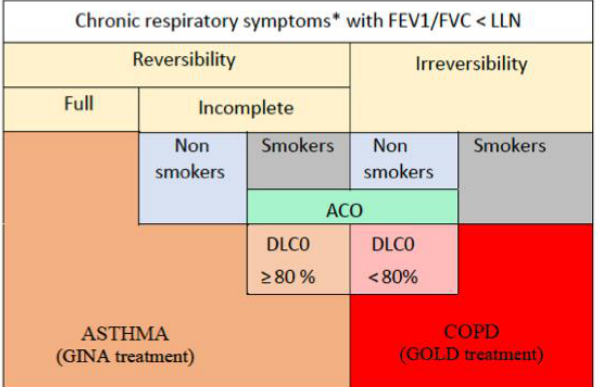
Figure 4. The strategy to select GINA or GOLD treatment among Vietnamese patients with chronic obstructive respiratory diseases based on symptoms, spirometry with response to BD, cumulative smoking and DLCO measurement among ACOs. GINA: Global Initiative for Asthma. GOLD: Global Initiative for Chronic Obstructive Lung Disease guidelines. COPD: chronic obstructive pulmonary disease. ACO: asthma — COPD overlap. * chronic respiratory symptoms: cough and/or sputum and/or dyspnea and/or wheezing and/or chest tightness lasting > 3 months.